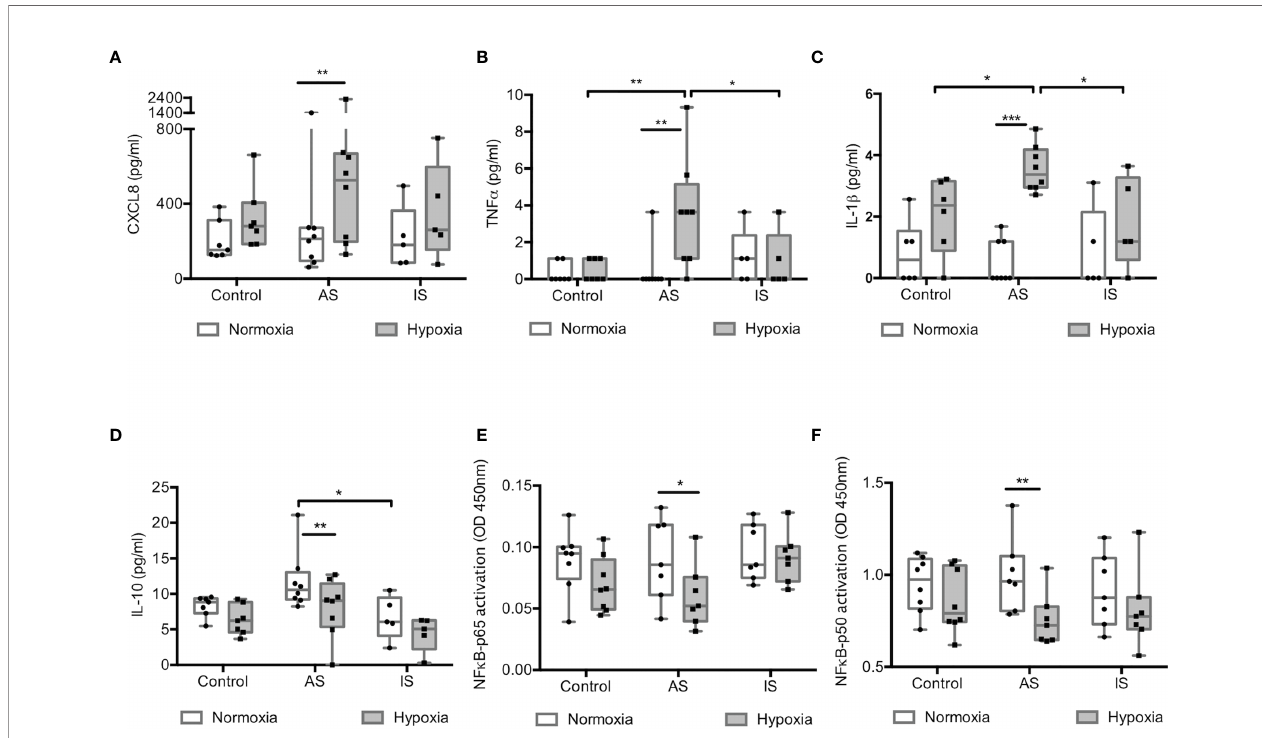
FIGURE 4 | Hypoxia induced a pro-in fl ammatory response without activation of NF- k B in high active sarcoidosis. (A – D) Concentrations of CXCL8 (A) , TNF a (B) , IL-1ß (C) and IL-10 (D) assessed by Luminex ® in conditioned media of normoxic and hypoxic MD-macrophages from controls, high active sarcoidosis (AS), and low active or inactive sarcoidosis (IS); results are expressed in pg/ml (n= 5-8 controls or patients/group). (E, F) NF- k B-p65 and p50 activation (measured as OD450nm) assessed by TransAM ® . Each point indicates a patient and/or control (n= 7-8/group). Results are expressed as box plot showing 25 th and 75 th percentile and median. *p < 0.05; **p < 0.01; ***p < 0.001 in two-way ANOVA-repeated measures with Sidak post-hoc